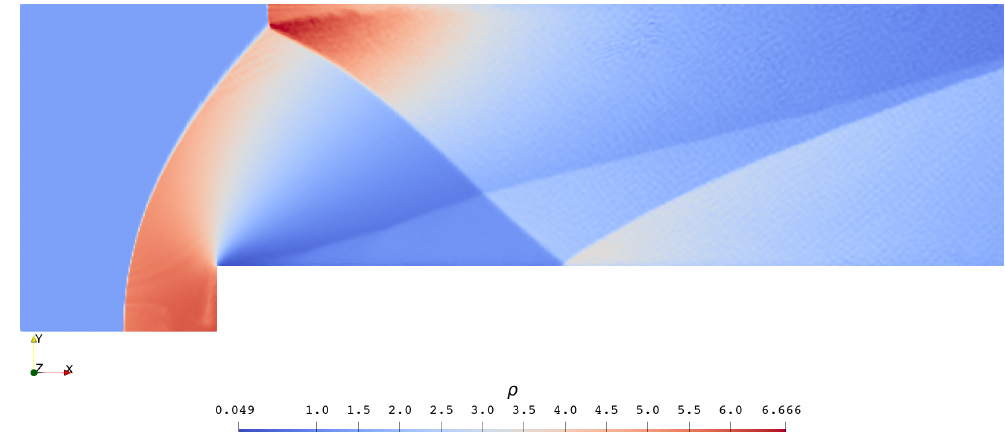
Figure 15. Third-order solution of Problem 4 at t = 2.0 on an h = 1/200 mesh.